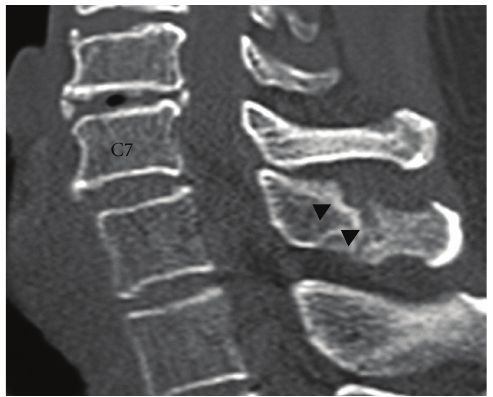
Figure 1: A sagittal reconstructed computed tomogram (CT). Nonunion of the T1 spinous process fracture (arrowheads) and slight anterolisthesis of C7/T1 are